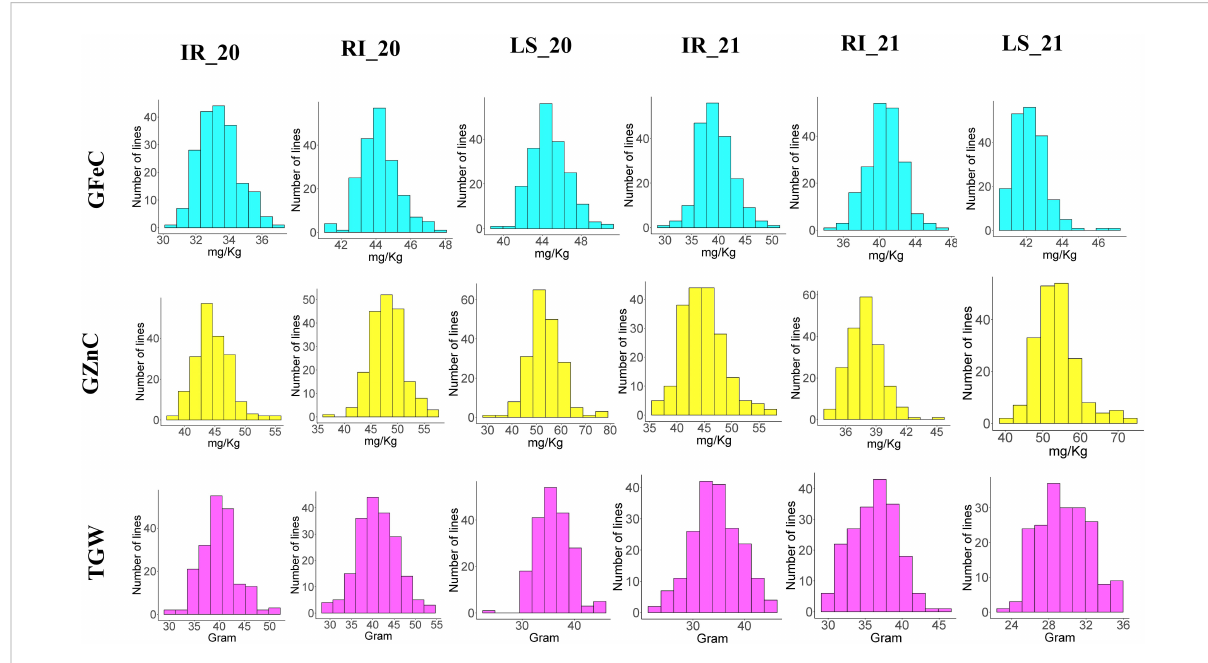
FIGURE 2 Histogram showing the frequency distribution of all the studied traits across the six